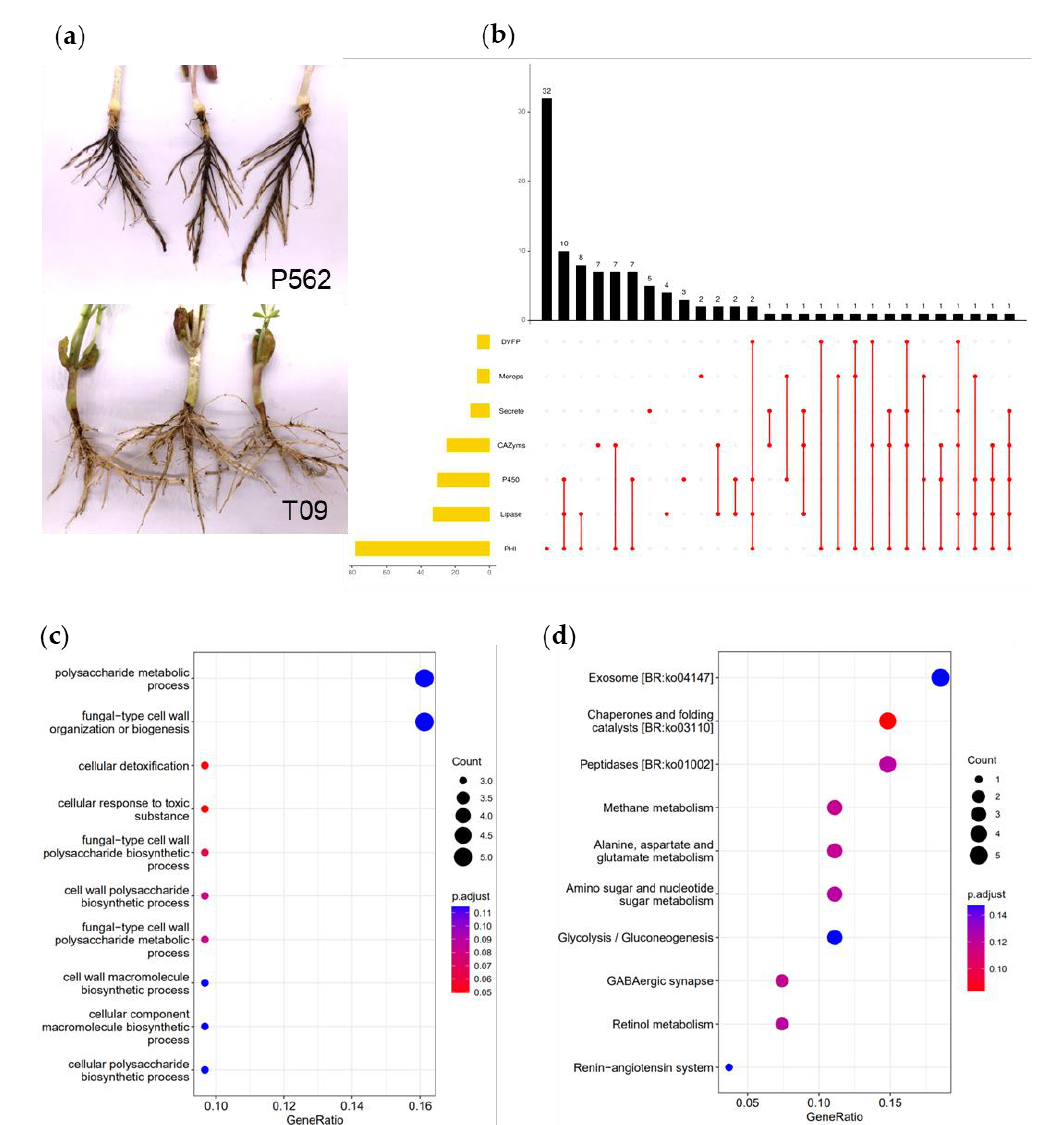
Figure 5. Identification of 46 differentially expressed factor for optimal CBR development. ( a ) Mediate resistance traits of peanut T09 to Ci 14017. ( b ) Venn analysis of 1146 genes matching the virulence- associated database. The values of the black vertical bar chart indicated the number of matching genes in one to seven databases, while the values of the yellow horizontal bar chart indicate the total number of matching genes in one database. The dots represent the genes that match the which